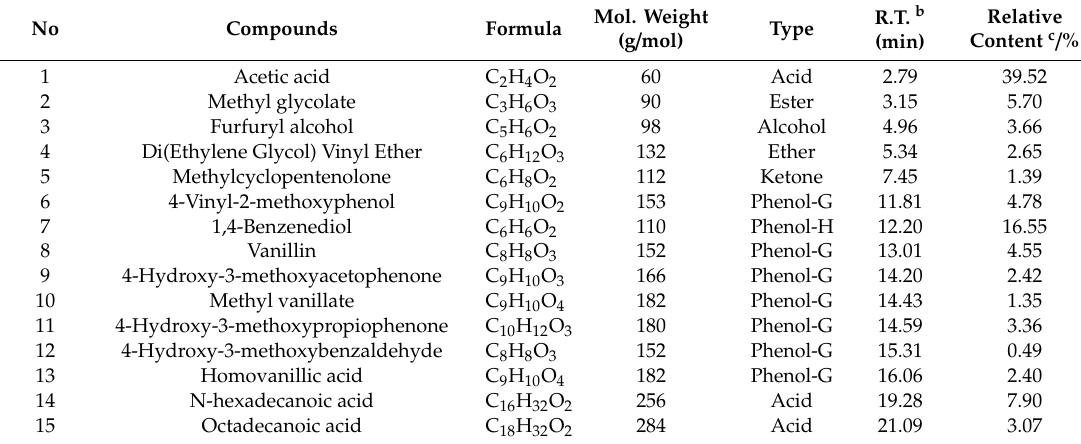
Table 3. GC-MS analysis of bio-oil a .